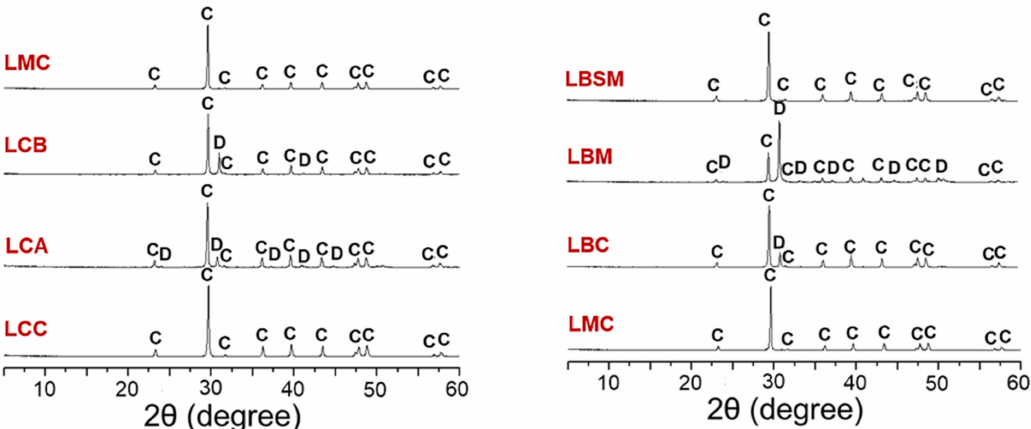
Figure 1. X-ray diffraction patterns of limestones. C—calcite, D—dolomite.